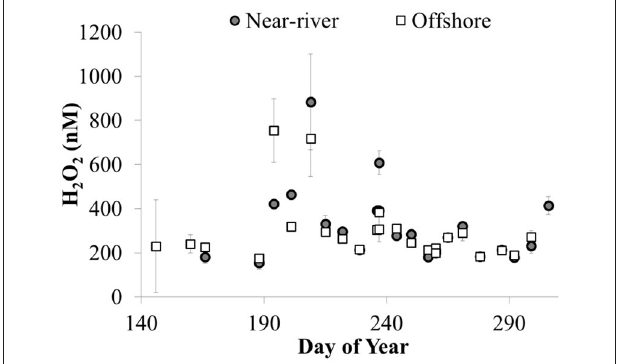
FIGURE 11 | H 2 O 2 concentrations (nM) at nearshore (site 12) and offshore (site 4) stations plotted vs. day of year in 2014 (average ± SE, n = 4